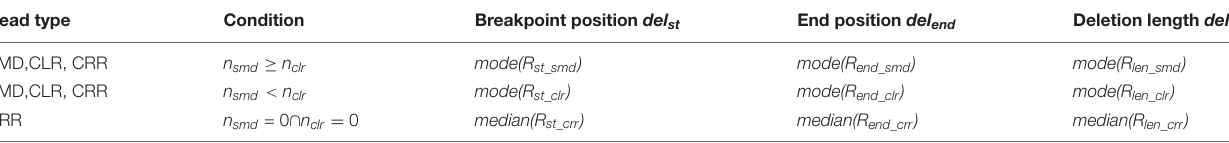
TABLE 1 | Strategy for determining breakpoint for informative read in one cluster. Read type Condition Breakpoint position del st